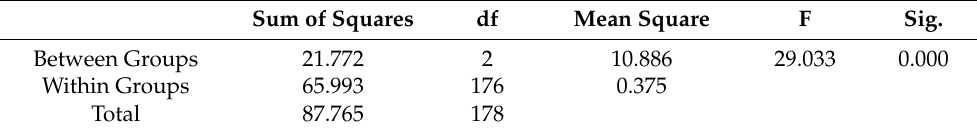
Table 4. ANOVA. Sum of Squares Mean Square